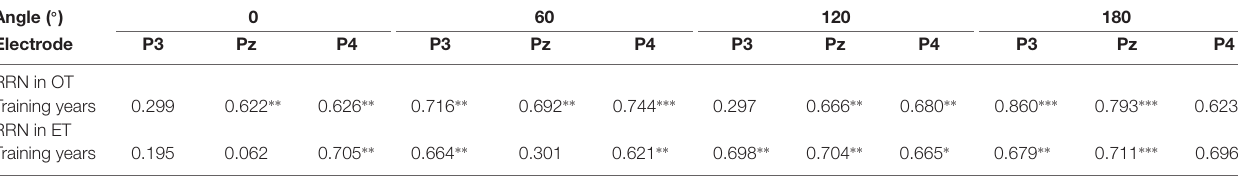
TABLE 6 | Values of correlation coefficients between RRN amplitude and training years in OT and ET conditions. Angle ( ◦